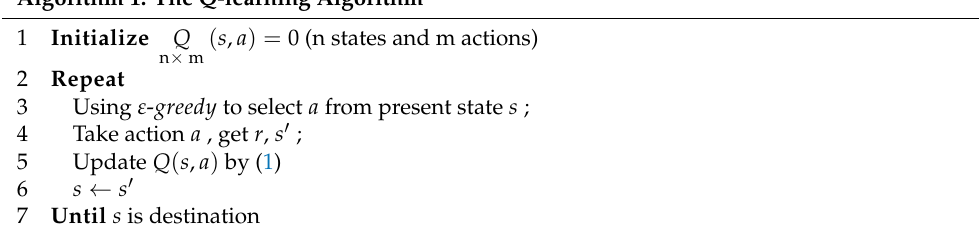
Algorithm 1: The Q-learning